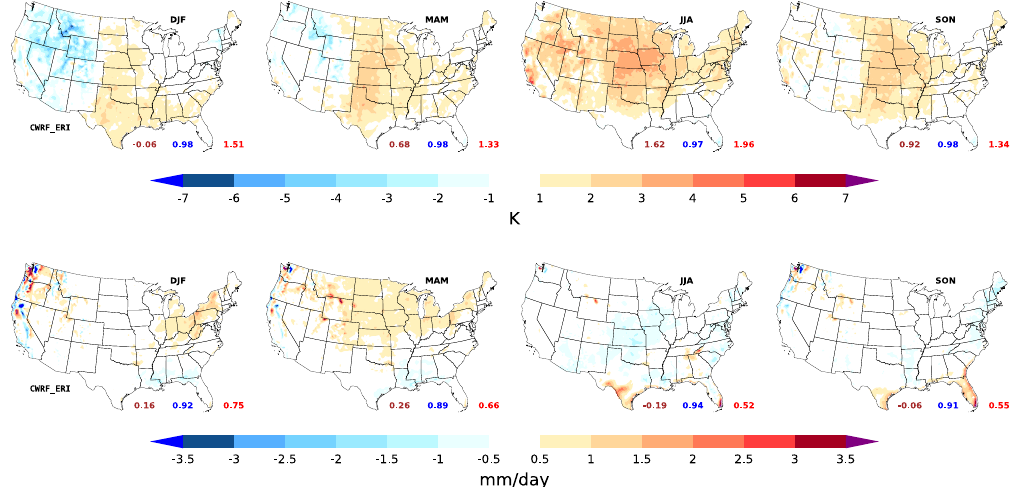
Figure 3. Differences (modeled – observed) of 20-year average T2 (top) and precipitation (bottom) over the contiguous U.S. for winter (DJF), spring (MAM), summer (JJA), and fall (SON). Numbers in brown, blue, and red represent the bias, correlation coefficient, and root mean square error (RMSE), respectively.